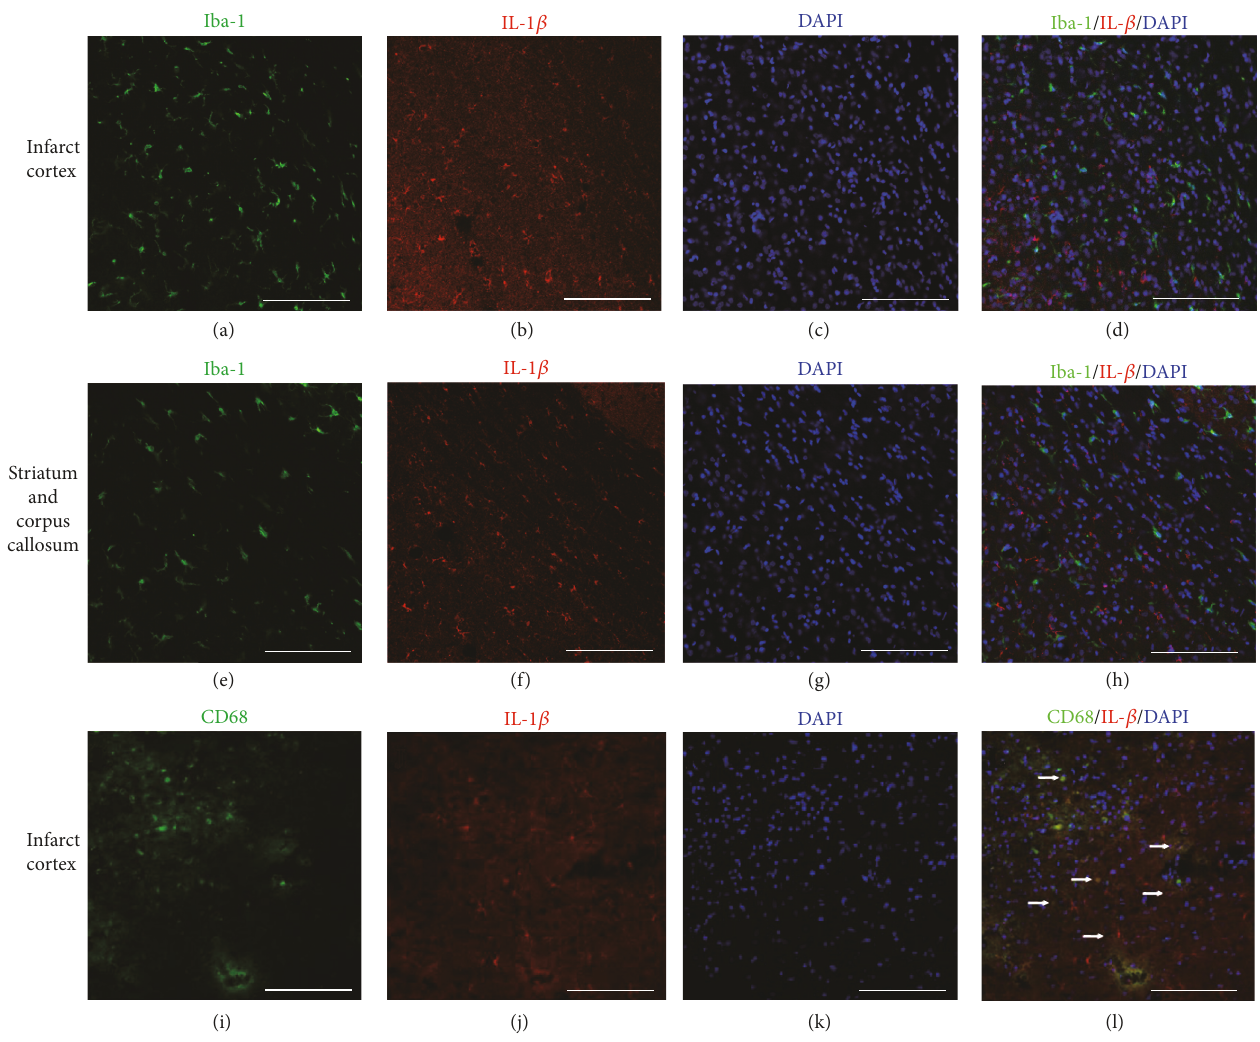
Figure 7: CD68 + microglia but not Iba-1 + cells express IL- β in the ischemic ipsilateral hemisphere at day 2. (a – d) Distribution of Iba-1 + cells and IL- β + cells in the infarct areas after MSC transplantation. (e – h) Distribution of Iba-1 + cells and IL- β + cells in the striatum after MSC transplantation. (i – l) Distribution of CD68 + cells and IL- β + cells in the infarct areas after MSC transplantation. (a, e) Iba-1 staining. (i) CD68 staining. (b, f, j) IL- β . (c, g, k) DAPI nucleus staining. (d) No double-stained Iba-1 + /IL- β + cells were found in the infarct area after dMCAO. (h) No Iba-1 + /IL- β + cells were found 2 days after MSC transplantation in the striatum and corpus callosum after MSC transplantation. (i – l) Some CD68 + cells were positive for IL- β . Arrow: double-labeled cells. Scale bar, 250 μ